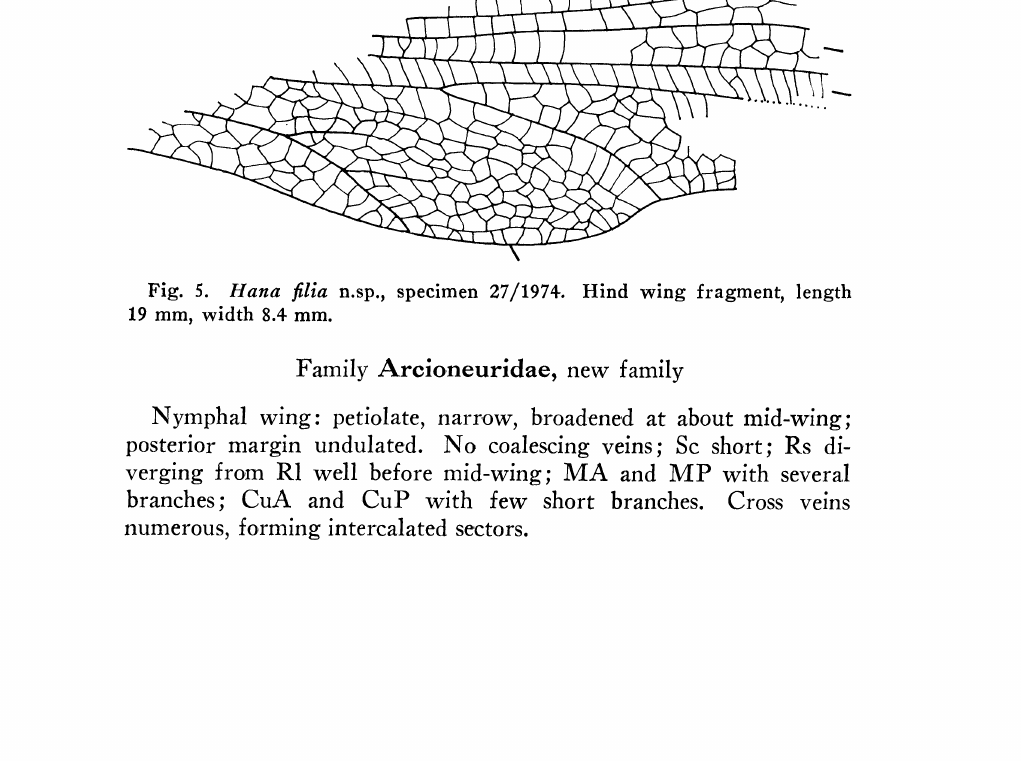
Fig. 5. Hana filia n.sp., specimen 27/1974. Hind wing fragment, length 19 mm, width 8.4